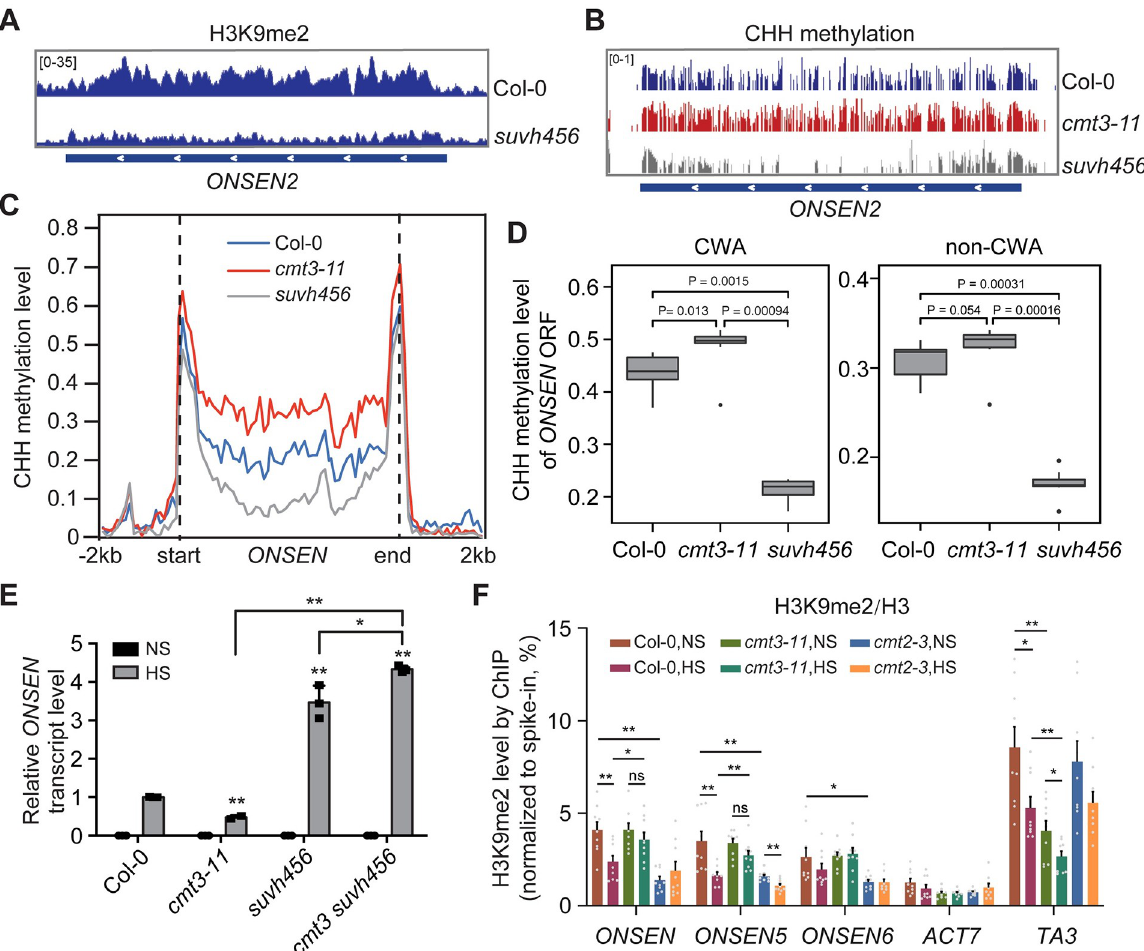
Fig 5. CMT3-mediated ONSEN activation is regulated by H3K9 methylation. (A) Genome browser view of H3K9me2 abundance at ONSEN in Col-0 and the SUVH4, SUVH5, and SUVH6 loss-of-function mutant ( suvh456 ). (B) Genome browser view of CHH methylation at ONSEN2 in Col-0, cmt3-11 , and suvh456 . (C) Metaplots showing average CHH methylation of 8 ONSEN copies. -2kb indicates the upstream 2000 bp of the start site, and 2kb indicates the downstream of 2000 bp of the end site. (D) Boxplots showing CWA (CAA and CTA) and non-CWA CHH methylation level in Col-0, cmt3-11 , and suvh456 of the open reading frame (ORF) of all eight copies of ONSEN . P-values are from Wilcoxon test. (E) Relative ONSEN transcript level in the corresponding mutants under non-stress (NS) and heat stress (HS). The ONSEN transcripts were normalized to 18S rRNA . All bars represent mean + SD from three biological replicates. Student’s t -test. � P < 0.05, �� P < 0.01. (F) ChIP-qPCR showing H3K9me2 level at ONSEN in Col-0, cmt3 , and cmt2 under NS and HS. H3K9me2 ChIP samples were first normalized to parallel H3 ChIP, and then to the respective spike-in human chromatin. ACT7 served as a negative control. TA3 was used as a positive control. All bars represent mean + SEM from three biological replicates with all technical replicates shown. Student’s t -test, � P < 0.05; �� P < 0.01; ��� P < 0.001. ns indicates not